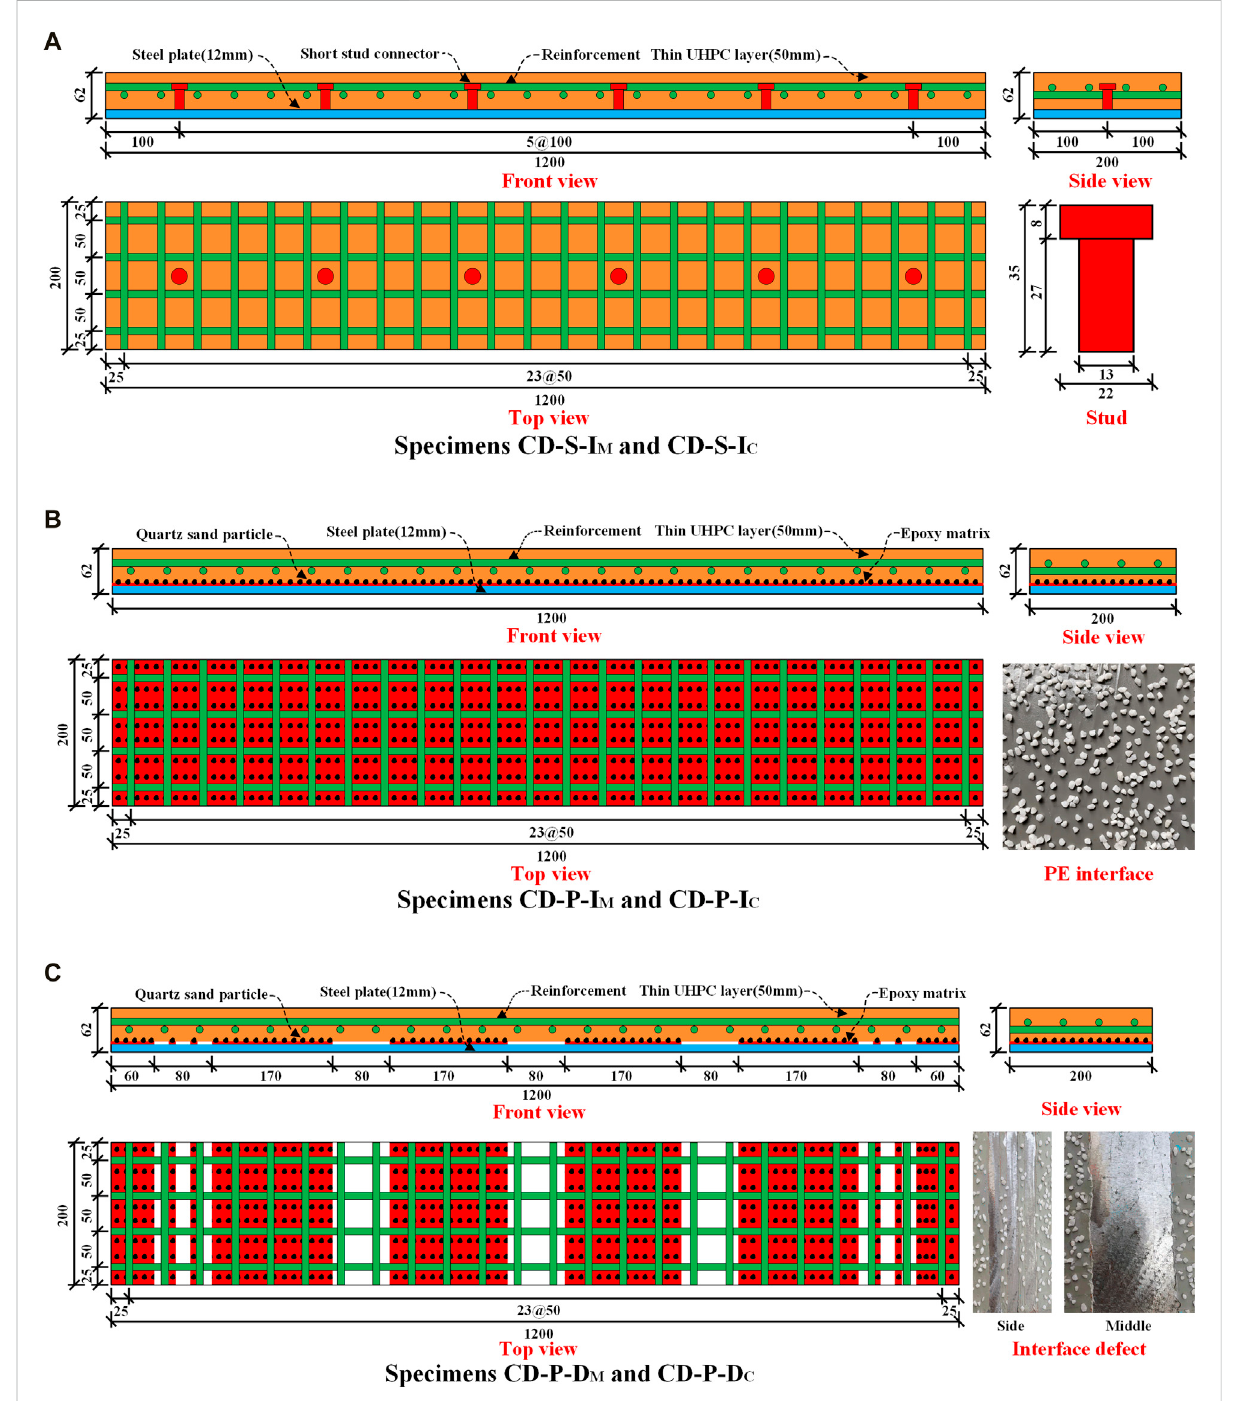
FIGURE 4 Steel-UHPC composite bridge deck. (A) Specimens CD-S-I M and CD-S-I C . (B) Specimens CD-P-I M and CD-P-I C . (C) Specimens CD-P-D M and